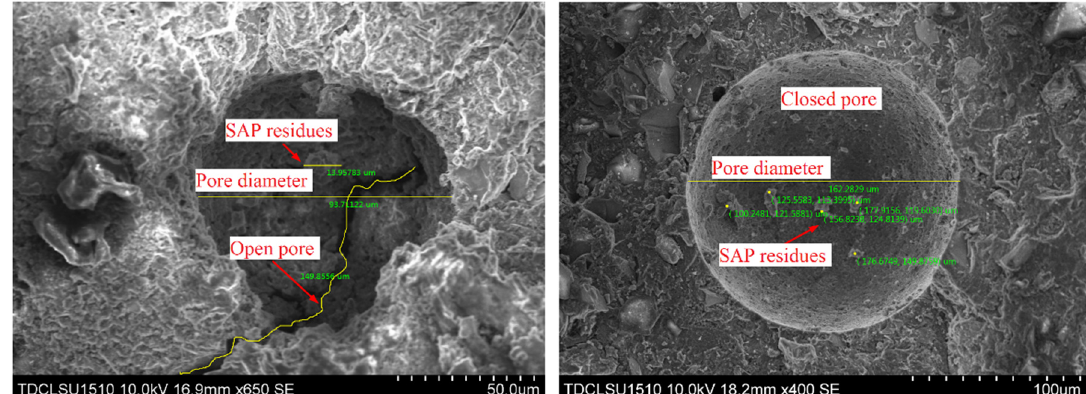
Figure 10. Single cavity connection (SEM).